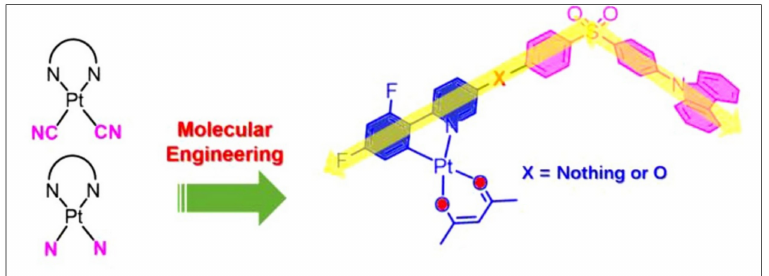
Figure 13. Molecular engineering scheme for the realization of external-stimuli-responsive OLED phosphors. Reproduced with permission from ref.